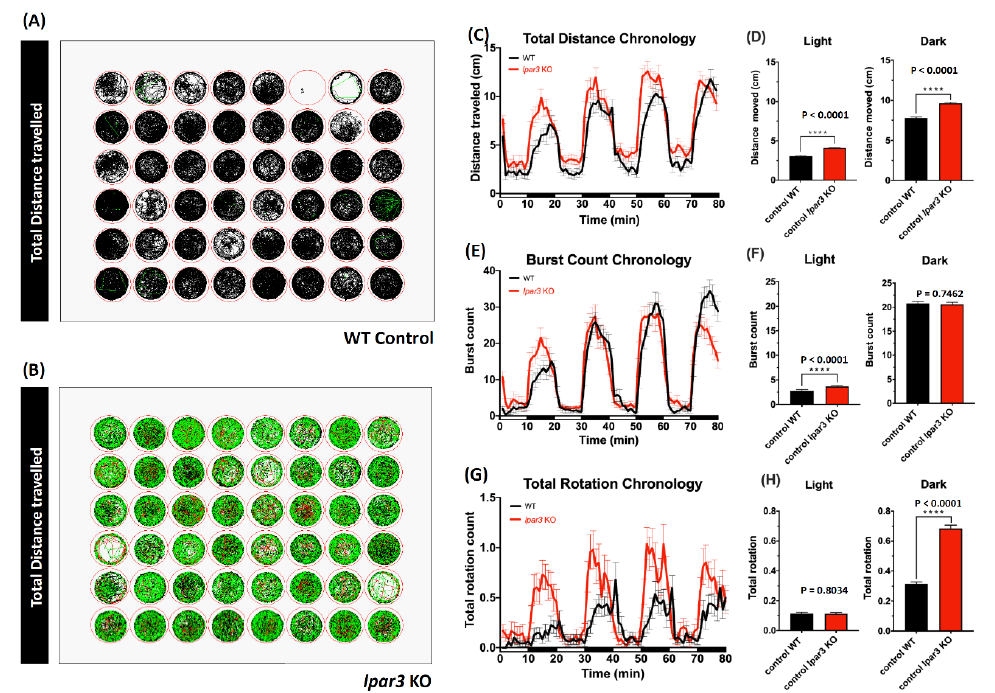
Figure 1. Comparison of behavior endpoints between wild-type and lpar3 knockout (KO) zebrafish larvae in the light/dark cycle behavior assay. Locomotor tracking for an 80 min recording is presented as a trajectory path for wild-type control ( A ) and lpar3 KO ( B ) . The movements are represented in different colors for different speeds (the black line refers to speeds under 5 mm/s, the green line refers to speeds from 5 to 20 mm/s, and the red line refers to speeds over 20 mm/s). Different endpoints are present in chronological changes of the total distance travelled ( C ), total burst count ( E ), and total rotation ( G ). Total locomotor activities in light and dark cycles were quantified and are presented as a total distance travelled ( D ), total burst count ( F ), and total rotation ( H ). Data are expressed as means ± standard error of the mean (SEM) and significant difference was test by the nonparametric Mann–Whitney test ( n = 48, **** p < 0.0001).